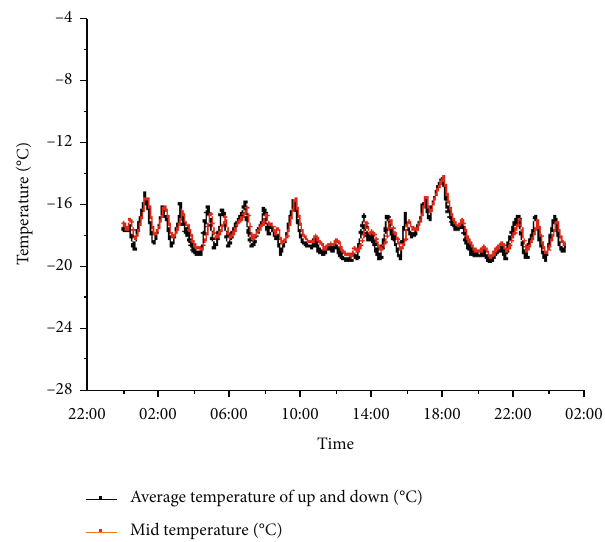
Figure 6: Average temperature and midtemperature of measuring points at vertical position 6.